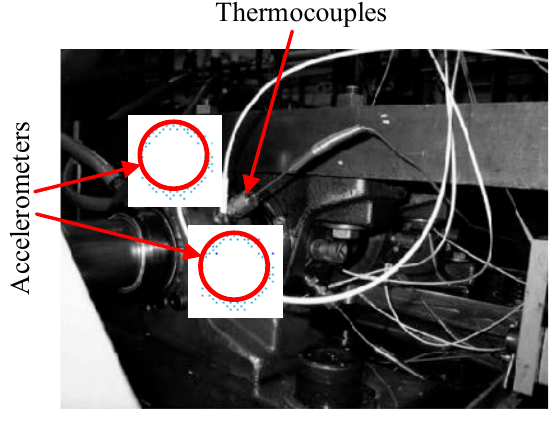
Figure 6. Schematic diagram of the sensor installation location.